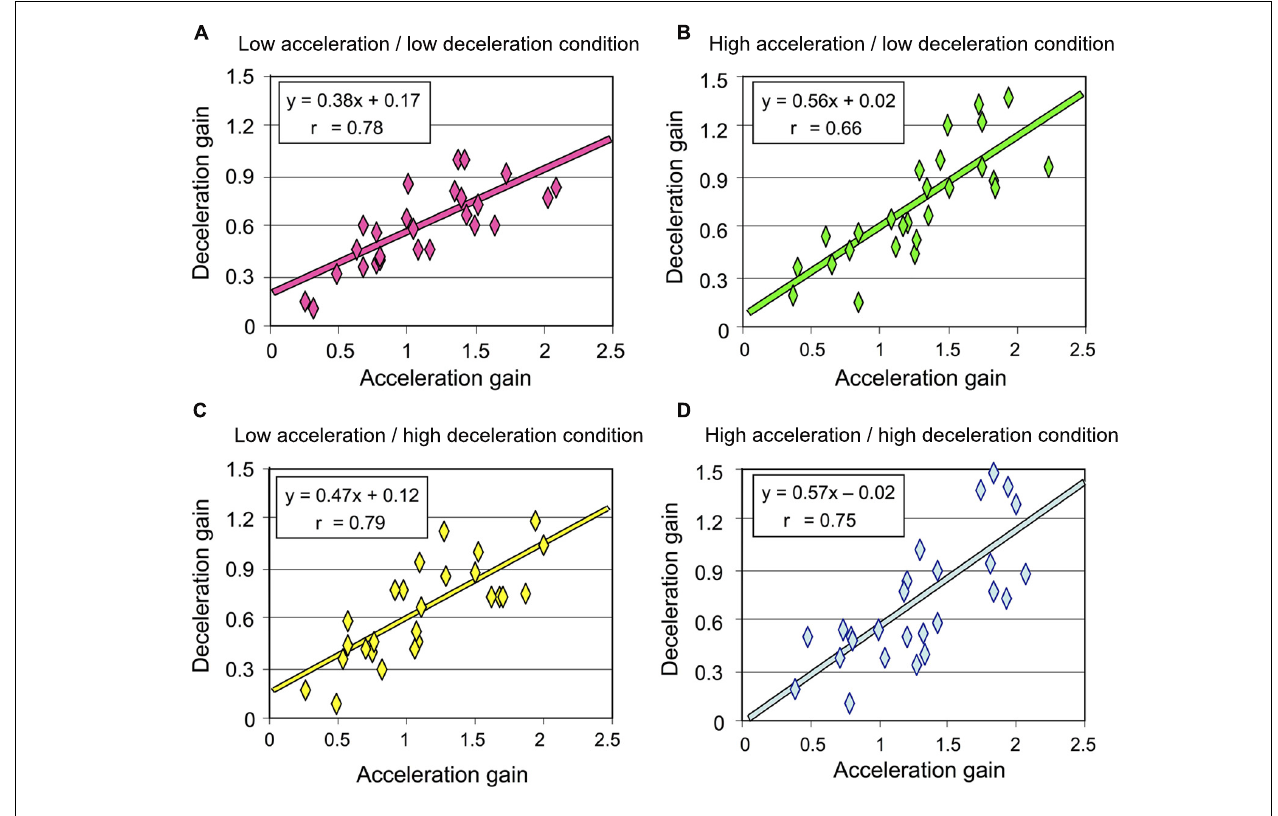
FIGURE 6 | Deceleration gain of all participants plotted against the acceleration in each rotational stimulus (combining counter-clockwise and clockwise rotations) (A) Low acceleration/low deceleration condition; (B) high acceleration/low deceleration condition; (C) low acceleration/high deceleration condition; (D) high acceleration/high deceleration